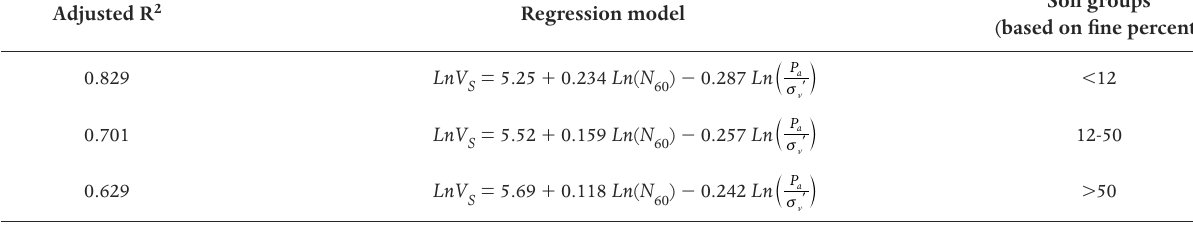
is natural logarithm of shear wave S